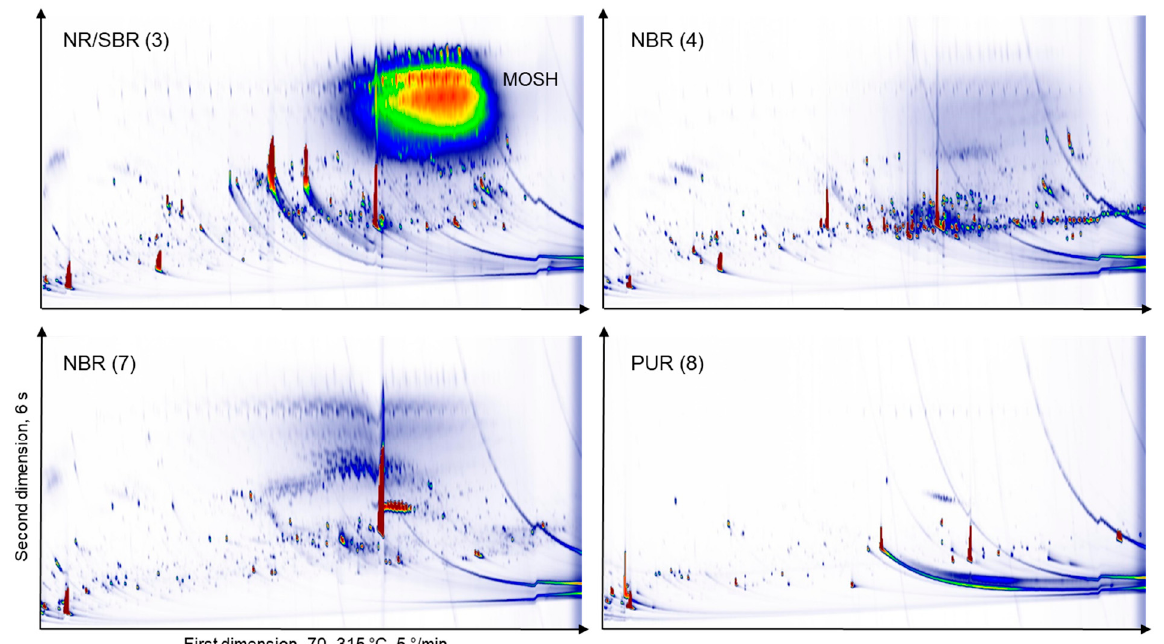
Figure 4. GC × GC-FID chromatograms of a selection of THF extracts without depletion of mineral oil saturated hydrocar- bons (MOSH) or mineral oil aromatic hydrocarbons (MOAH) by PTV injection. NR/SBR (natural rubber/styrene-butadiene rubber); NBR (acrylonitrile butadiene rubber); PUR (polyurethane rubber); SBS (styrene-butadiene-styrene).